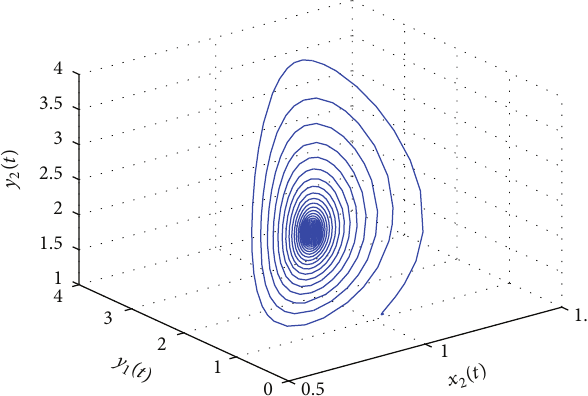
Figure 3: The phase plot of the states 𝑥 2 , 𝑦 1 , 𝑦 2 for 𝜏 1 = 4.2500 < = 4.5061 𝜏 10